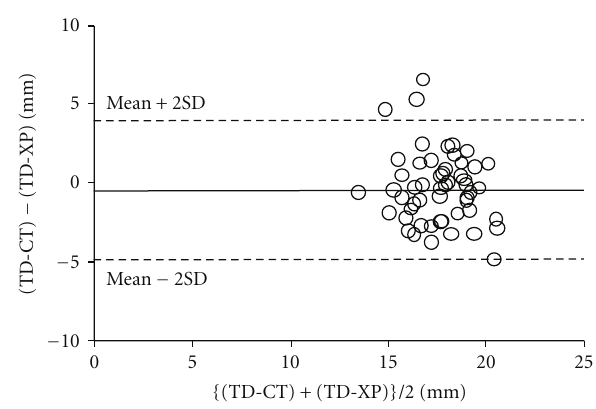
Figure 3: Bland-Altman analysis of TD-CT versus TD-XP in male. The solid line shows bias, and the dotted lines show the limit of agreement.